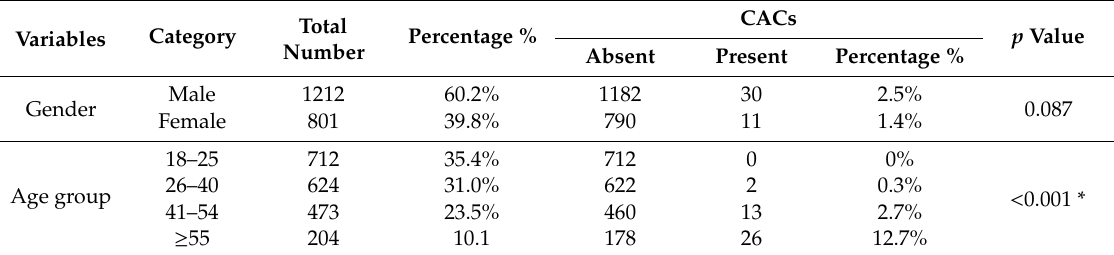
Table 1. Descriptive analysis of study variables and the relation to carotid calcifications (CACs) ( n = 2013).